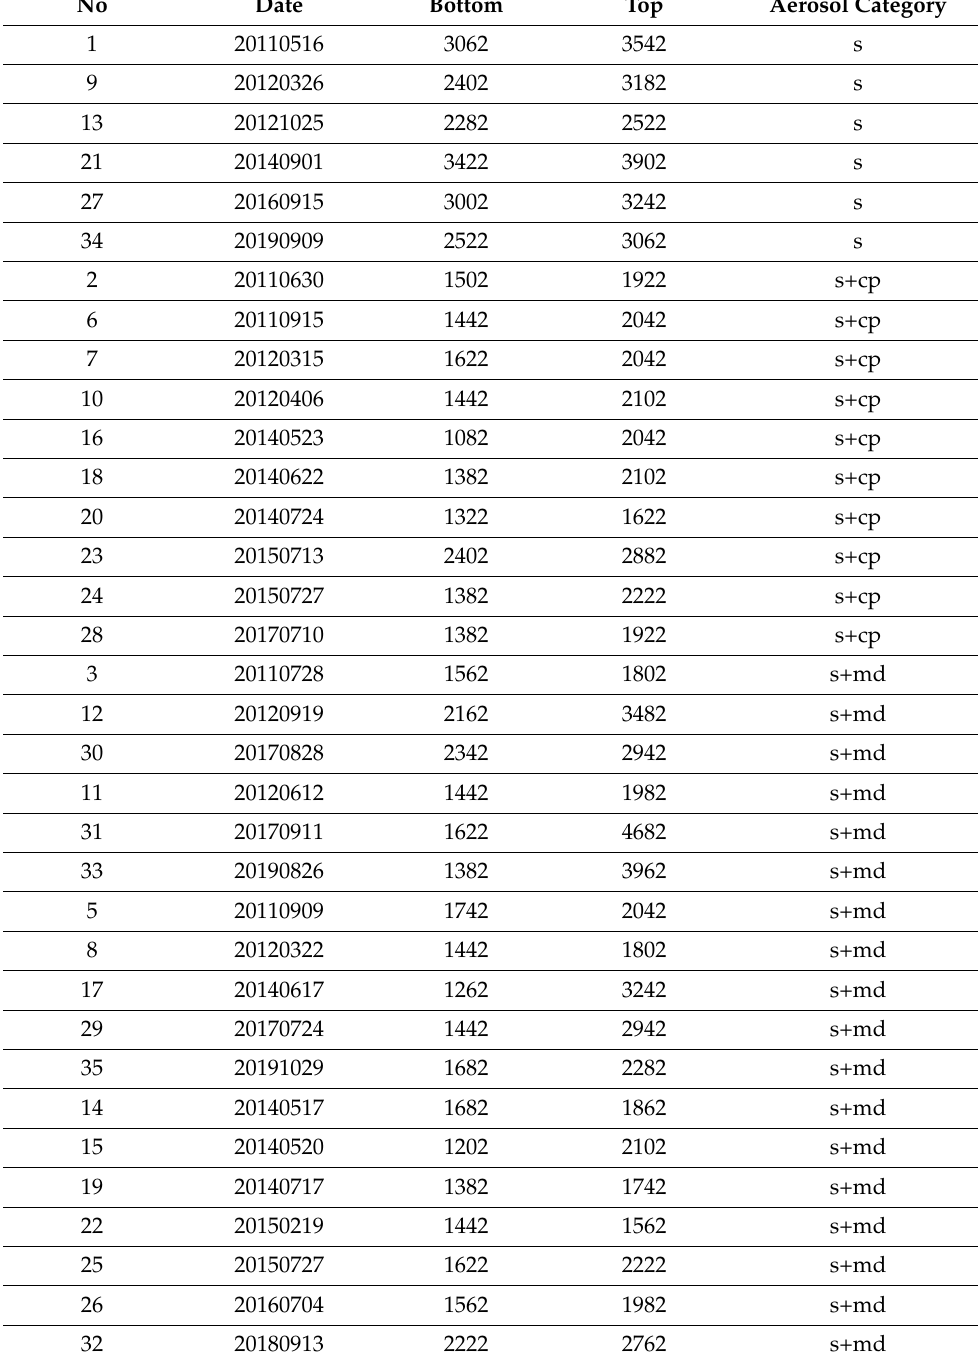
Table A1. Date, bottom, top, and aerosol category of each aerosol layer of this